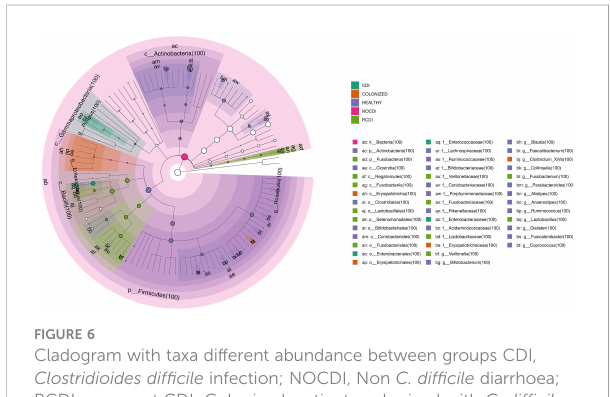
FIGURE 6 Cladogram with taxa different abundance between groups CDI, Clostridioides dif fi cile infection; NOCDI, Non C. dif fi cile diarrhoea; RCDI, recurrent CDI; Colonized, patients colonized with C. dif fi cile ; Healthy, Healthy